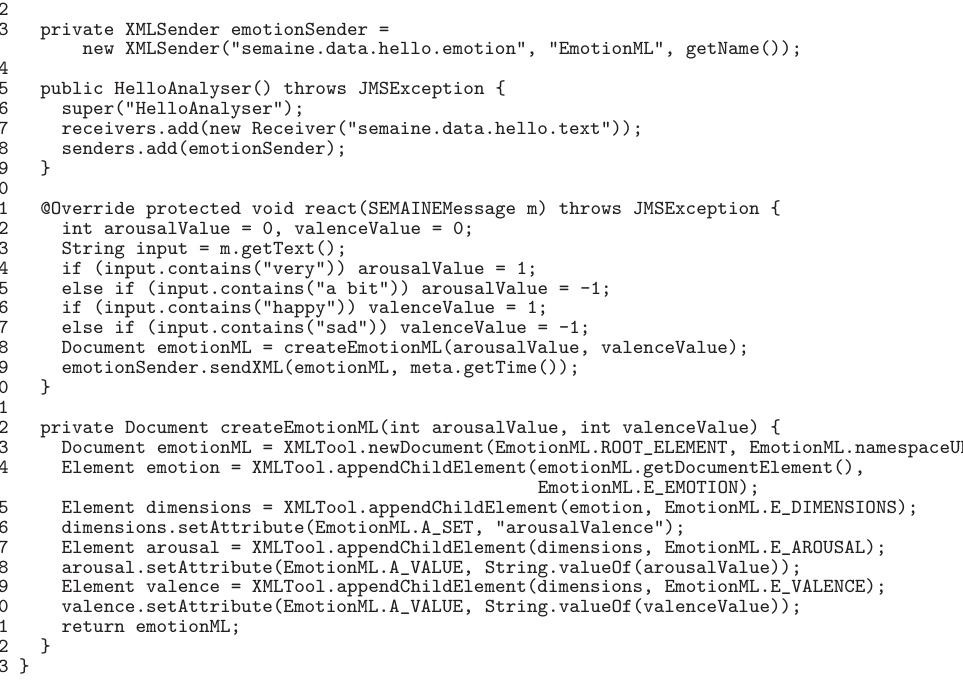
Figure 13: The HelloAnalyser component. It receives and analyses the text messages from HelloInput and generates and sends an EmotionML document containing the analysis results.